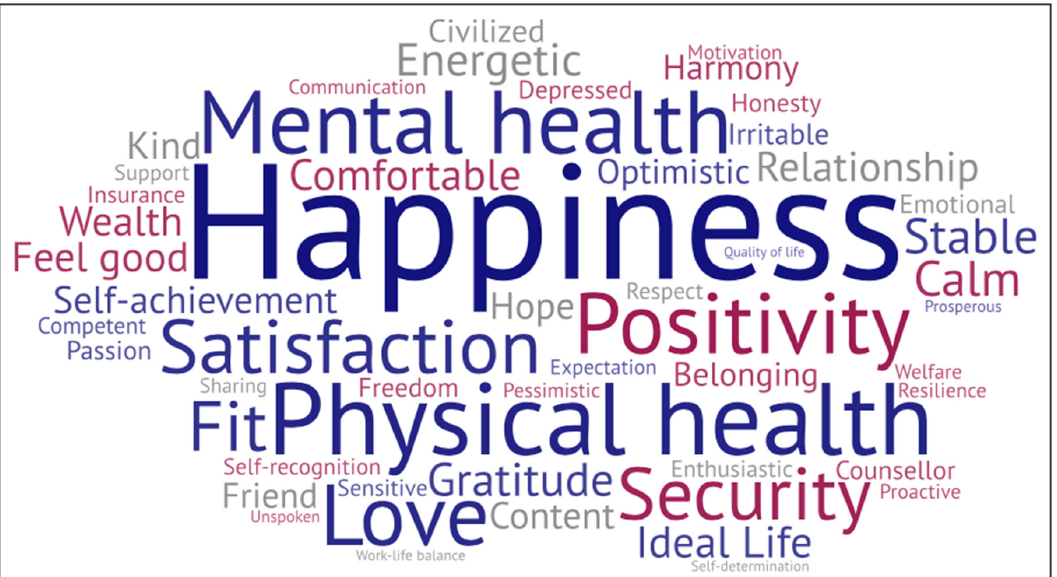
Figure 1. Words and phrases used by Chinese international students to communicate/describe wellbeing.